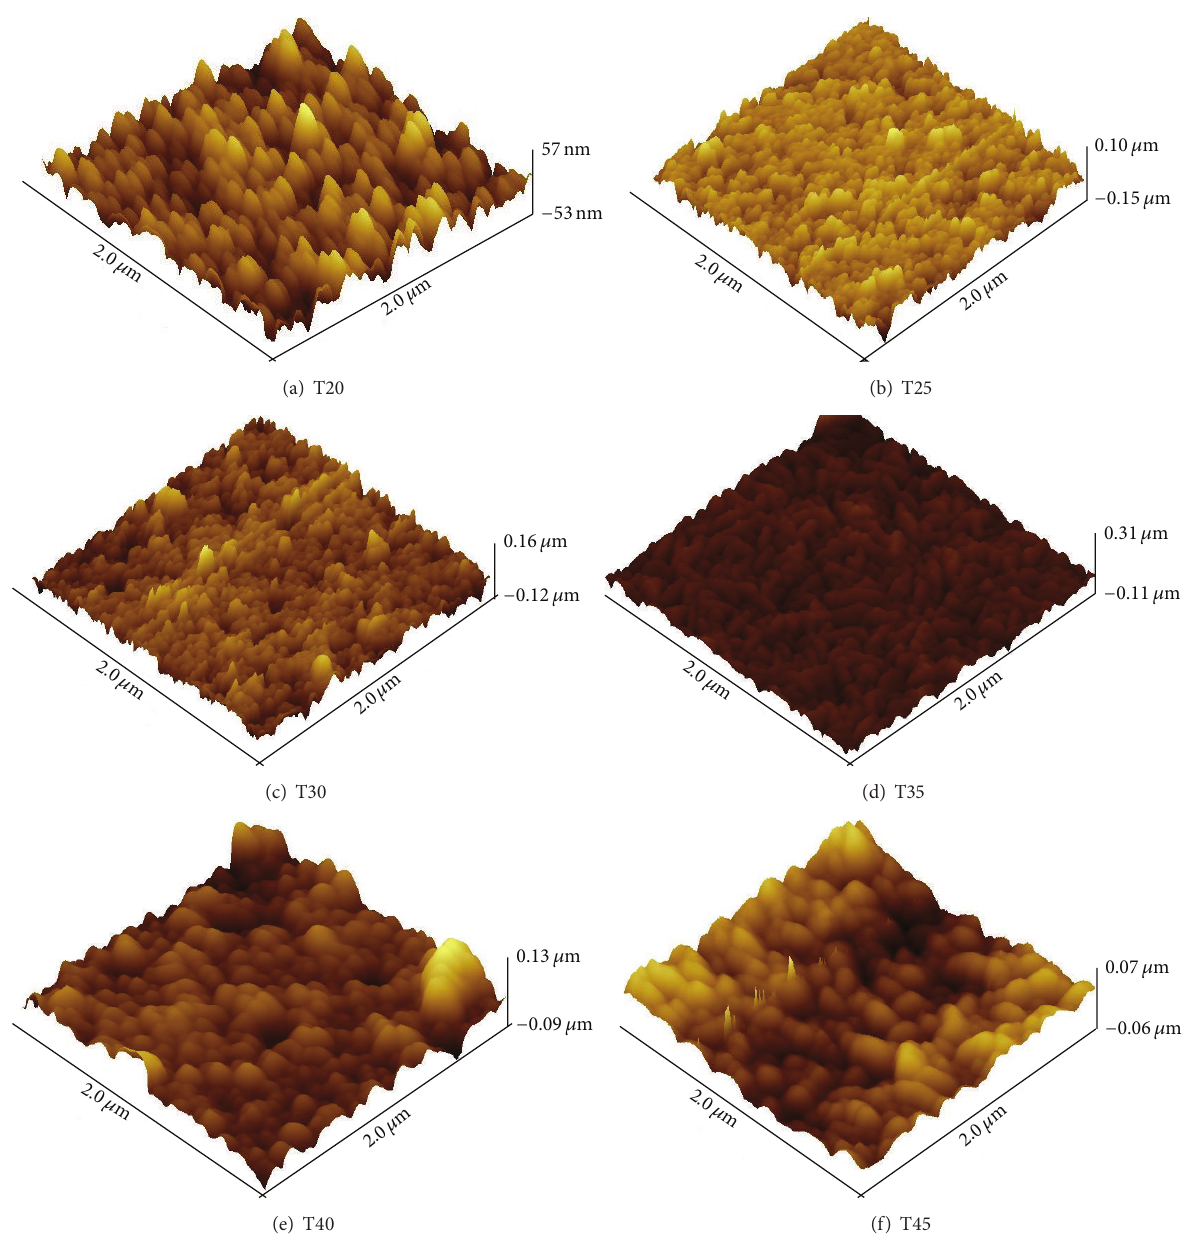
Figure 4: AFM images of TNAs prepared at different anodizing